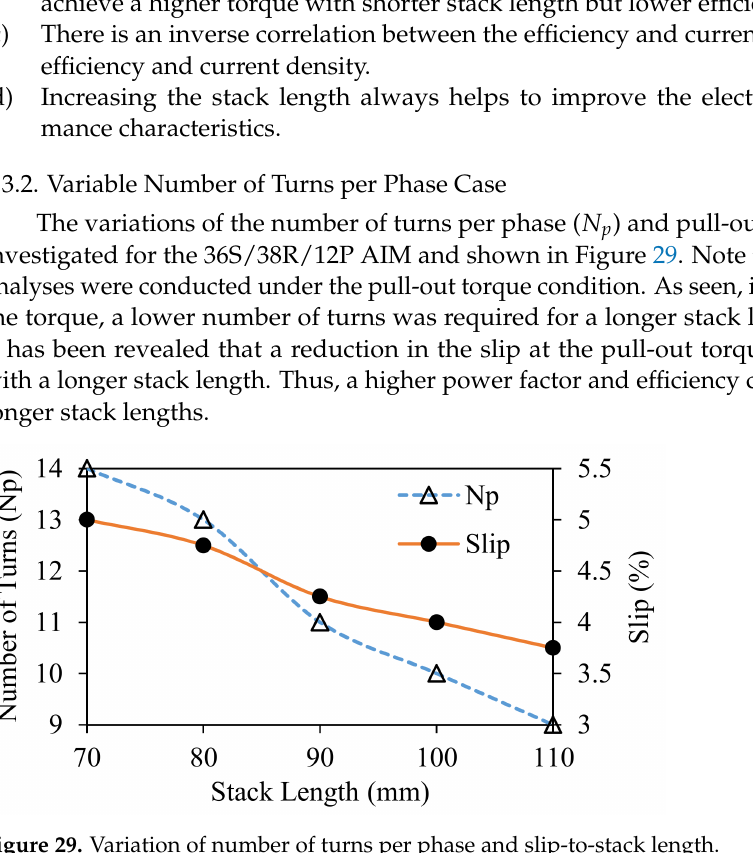
Figure 29. Variation of number of turns per phase and slip-to-stack